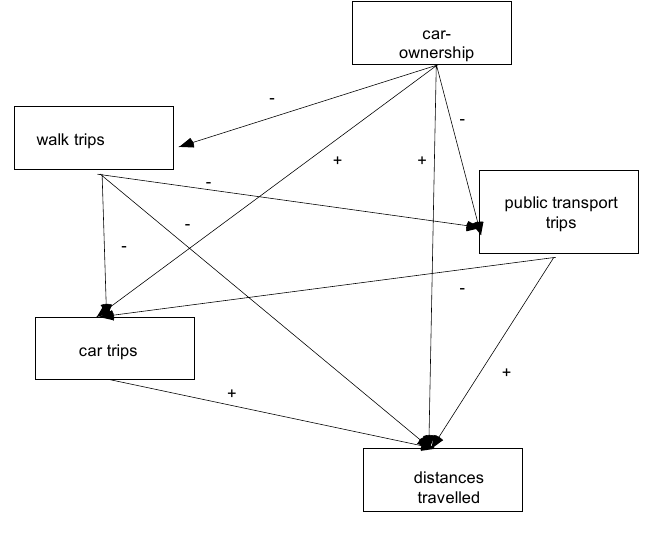
Figure 3. Generalised direct effects between the exogenous and endogenous variables